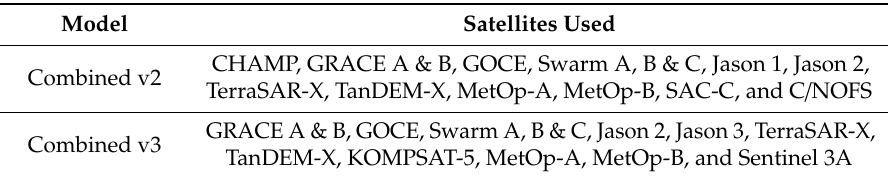
Table 3. Satellites used by ITSG to develop combined models of Earth gravity